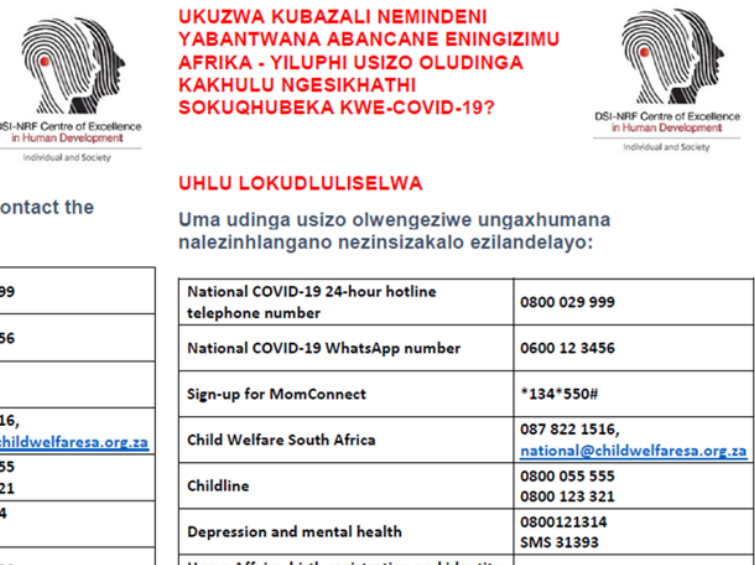
Figure 2. Support and referral services in English and